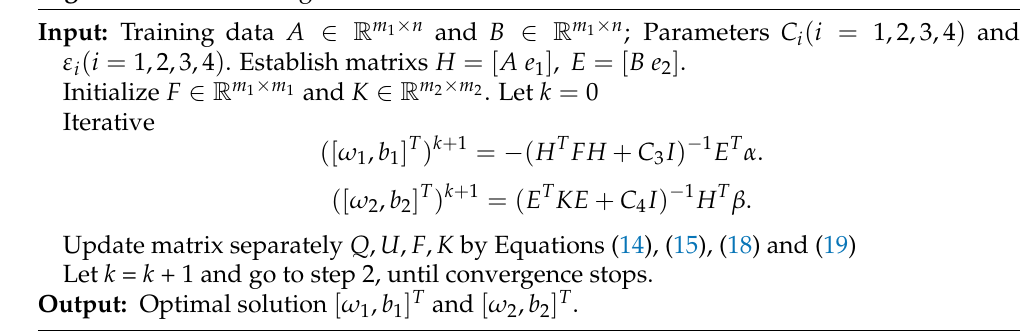
Algorithm 1 Iterative algorithm to solve